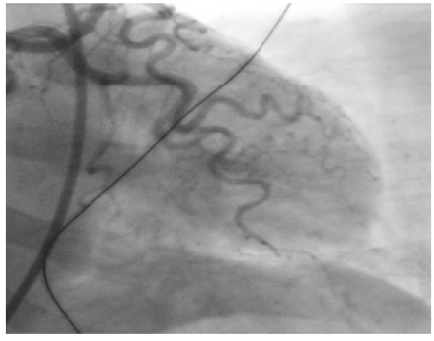
Figure 3: Coronary angiogram and left